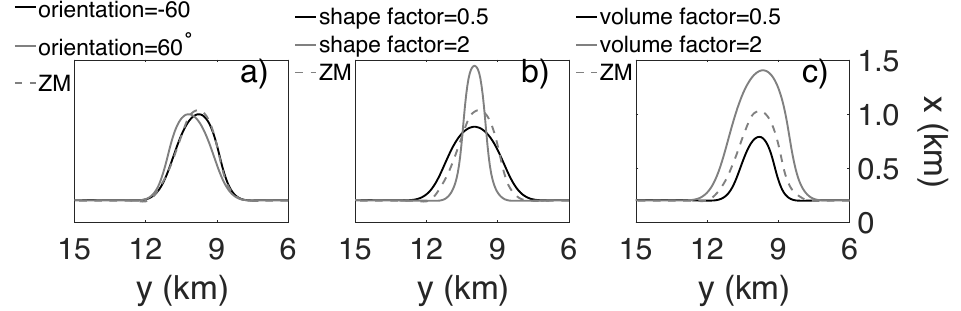
Figure 7. Sketch of the different initial mega-nourishment geometries, including variations on: ( a ) the orientation or asymmetry; ( b ) the shape factor; and ( c ) the volume factor. Notice that the scaling of both axis is not the same.